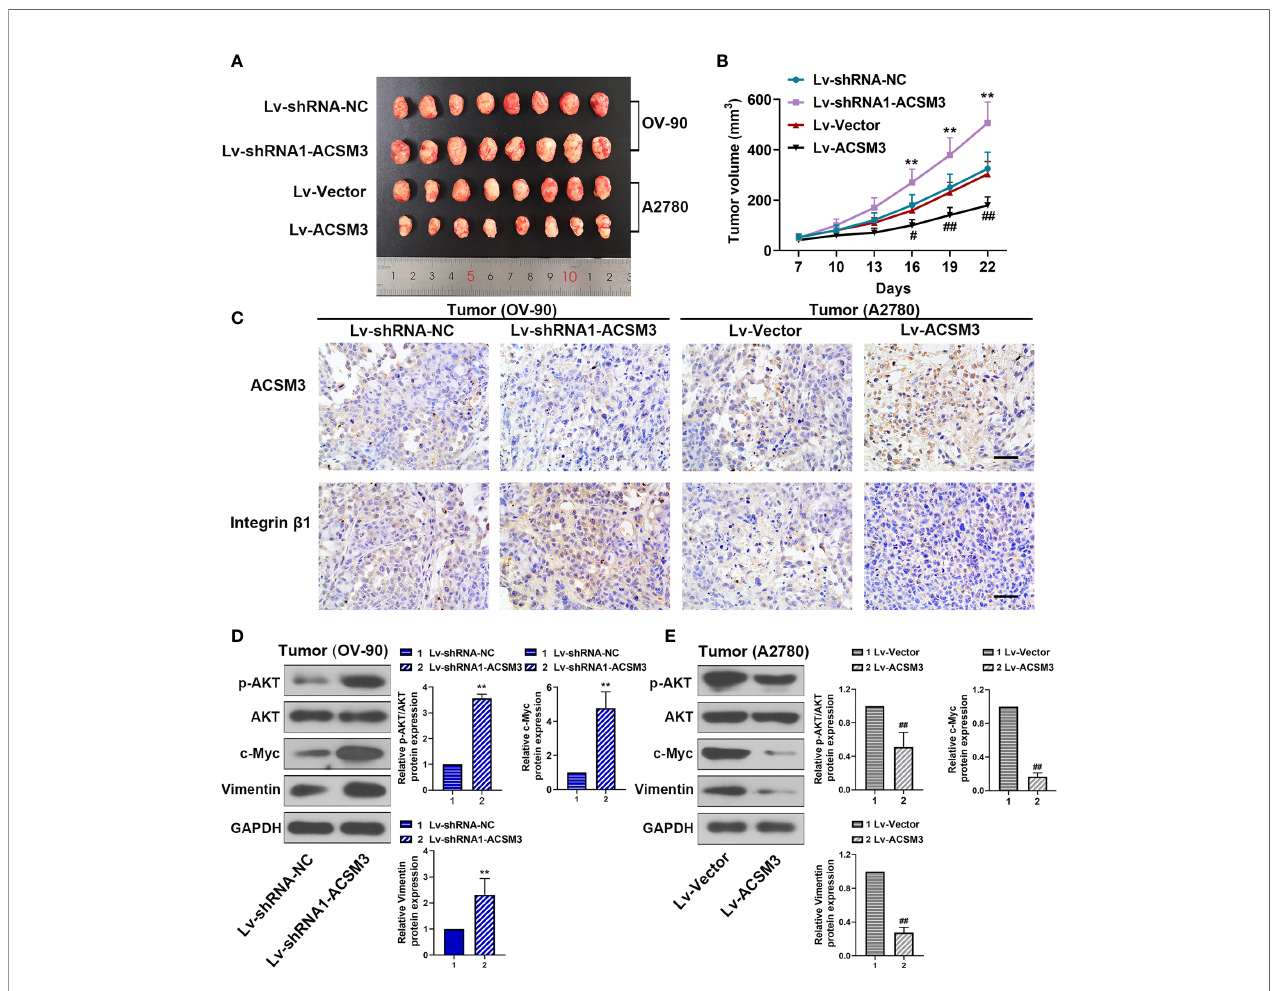
FIGURE 6 | Effects of ACSM3 on the growth of ovarian cancer tumor in vivo . A xenograft tumor model was built with OV-90 cells infected with Lv-shRNA1-ACSM3 or A2780 cells infected with Lv-ACSM3. (A, B) The volume of xenograft tumors. (C) The expression of ACSM3 and Integrin b 1 was measured by immunohistochemistry. Scale bar represented 50 m m. (D, E) Relative protein expression of p-AKT, AKT, c-Myc, Vimentin, and E-cadherin. Measurement data were expressed as mean ± SD of six independent experiments. **p < 0.01 versus Lv-shRNA-NC; # p < 0.05, ## p < 0.01 versus